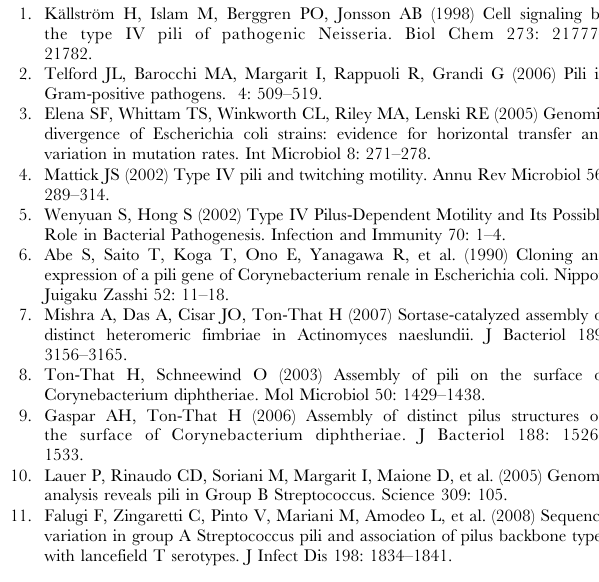
Table S1 Root mean square deviations (rmsd) of the three crystal forms of